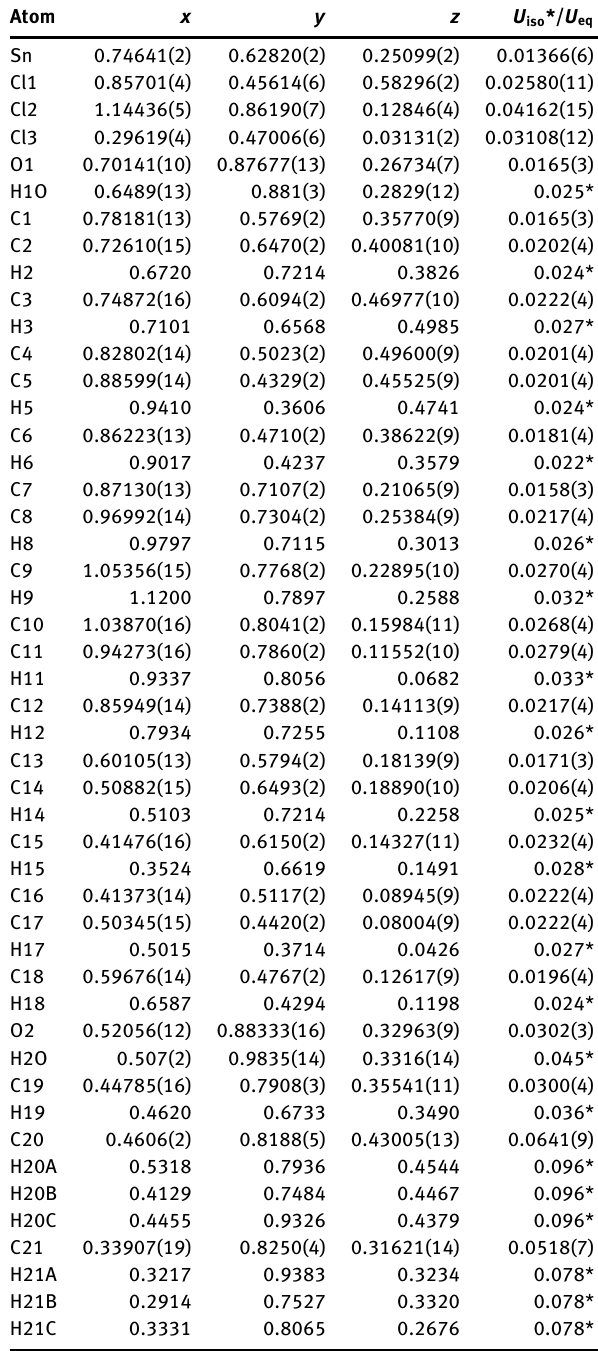
Table 2: Fractional atomic coordinates and isotropic or equivalent isotropic displacement parameters (Å 2